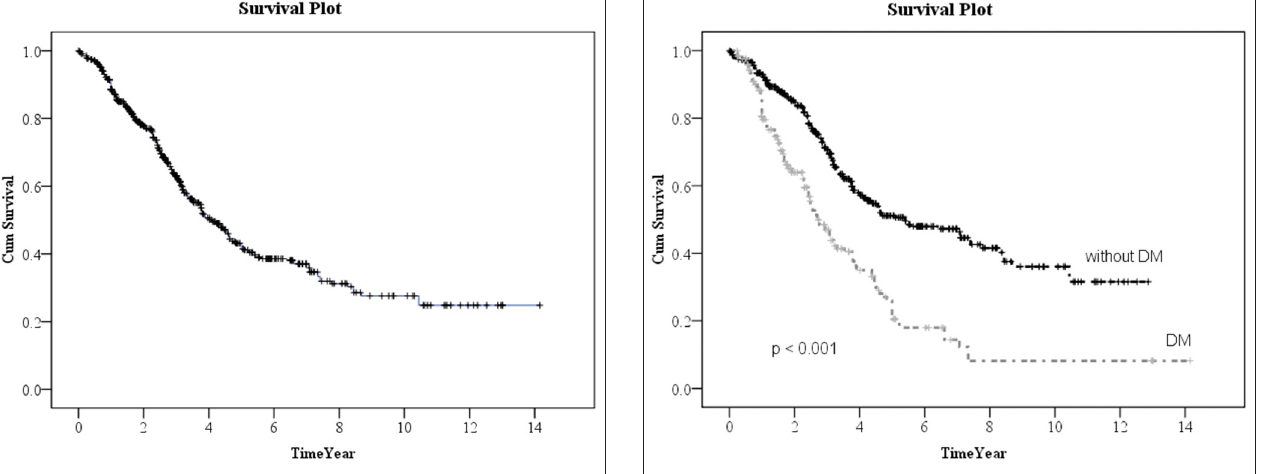
impact of comorbidity number on the PD catheter survival, which showed that the more comorbidity number, the lower PD catheter survival time ( Figure 5 ).